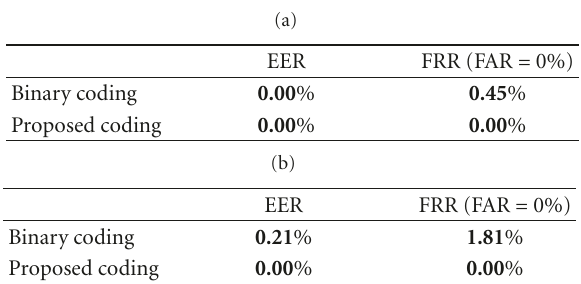
Table 2: EER and FRR (FAR = 0%) measured on (a) CASIA and (b) ISEP databases for a binary coding and the proposed